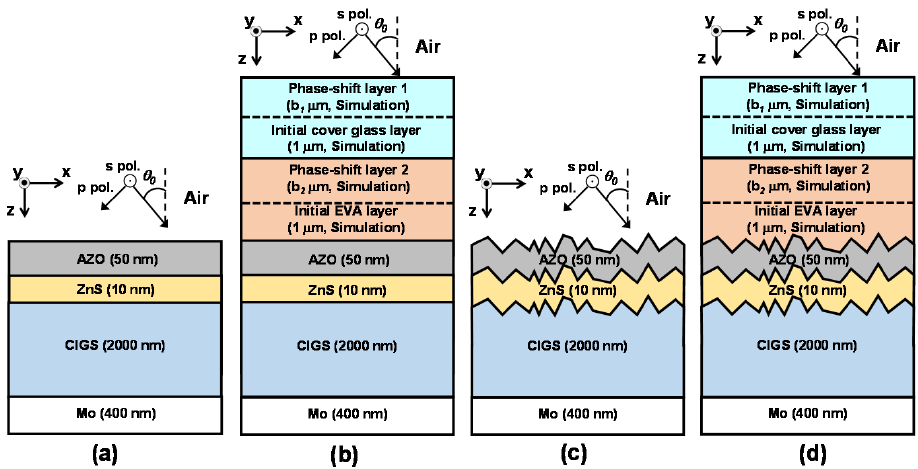
Figure 9. Four different device structures to investigate the effect of the front incoherent encapsulation layers on output performance of the planar and surface-textured CIGS solar cells. The RMS surface roughness of the surface-textured structure is σ RMS = 100 nm. The angular dependences of reflectance spectrum and J–V curves are calculated and compared in the surface-textured CIGS solar cell ( c ) without and ( d ) with the inclusion of the two front encapsulation layers. For reference, reflectance spectrum and J–V curves are also calculated in the planar CIGS solar cell ( a ) without and ( b ) with the inclusion of the two front encapsulation layers.